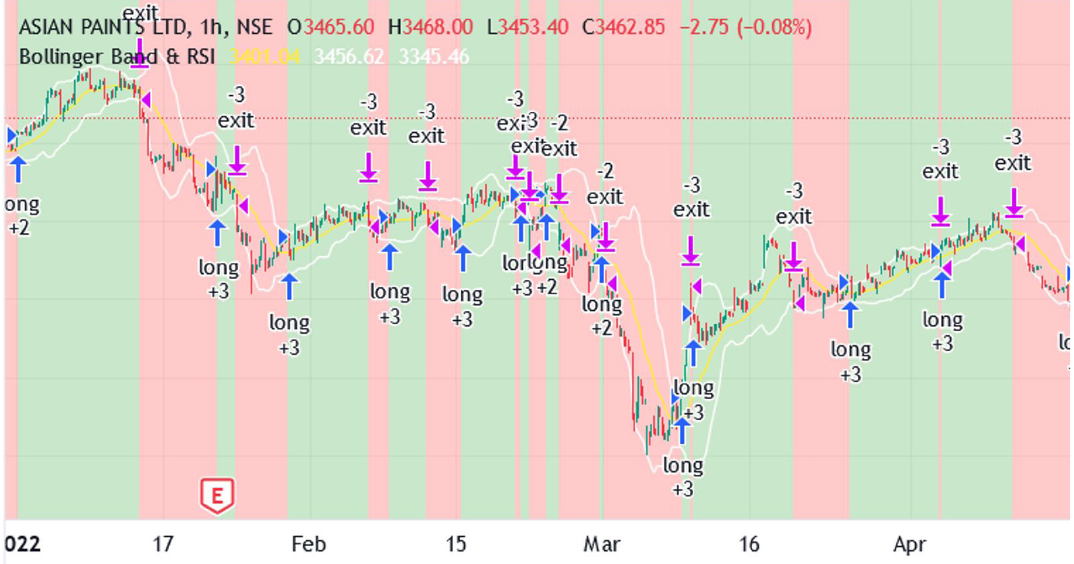
Figure 4. Bollinger Bands & RSI Strategy applied on Asian Paints